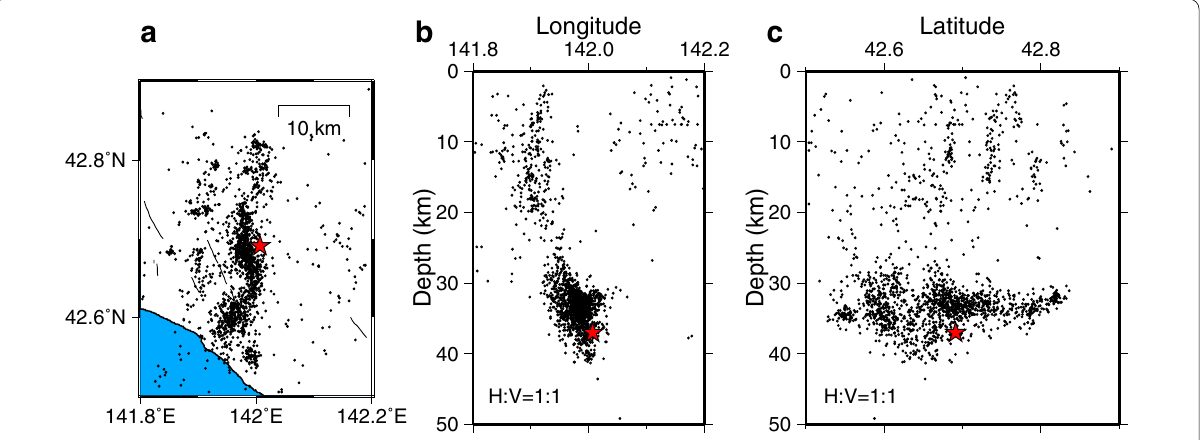
Fig. 3 Hypocenter distribution of aftershocks of the 2018 Hokkaido Eastern Iburi earthquake. a Epicenter distribution of aftershocks. A red star indicates the epicenter of the main shock. Thin solid lines are active faults (Research Group for Active Faults in Japan 1991). b Vertical cross section in East–West. A red star indicates the hypocenter of the main shock. c Vertical cross section in North–South. A red star indicates the hypocenter of the main